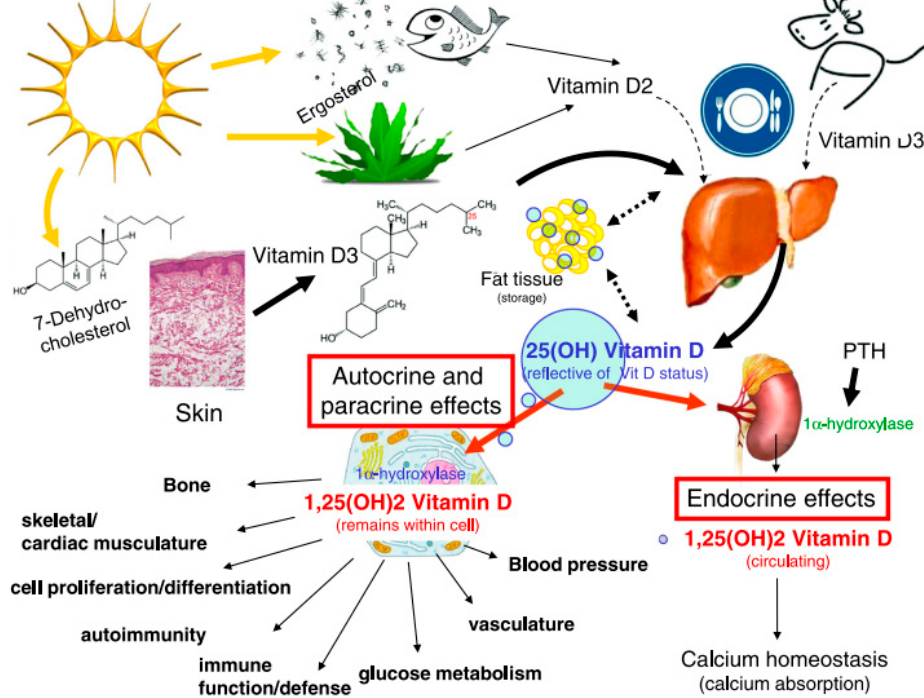
Figure 2. Scheme of vitamin D sources, fate in the body, and pleiotropic actions of 1,25-dihydroxy vitamin D (calcitriol), the active form of vitamin D. Reproduced with permission from [14]; published by Elsevier, 2011.